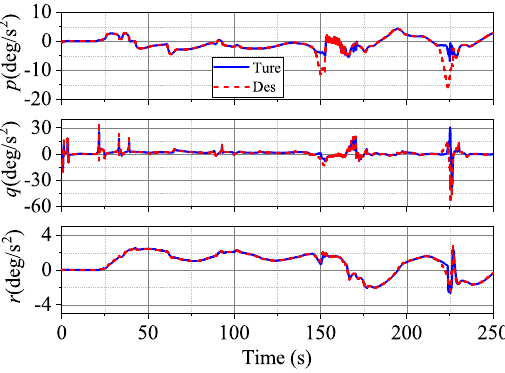
Figure 11. Results for p , q , and r without disturbances.